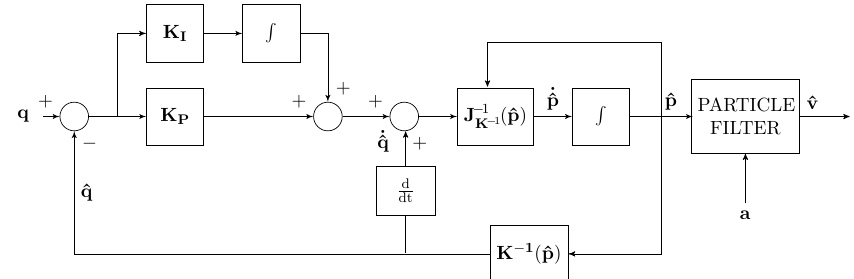
Figure 7. Test 5 estimator scheme with particle filter and